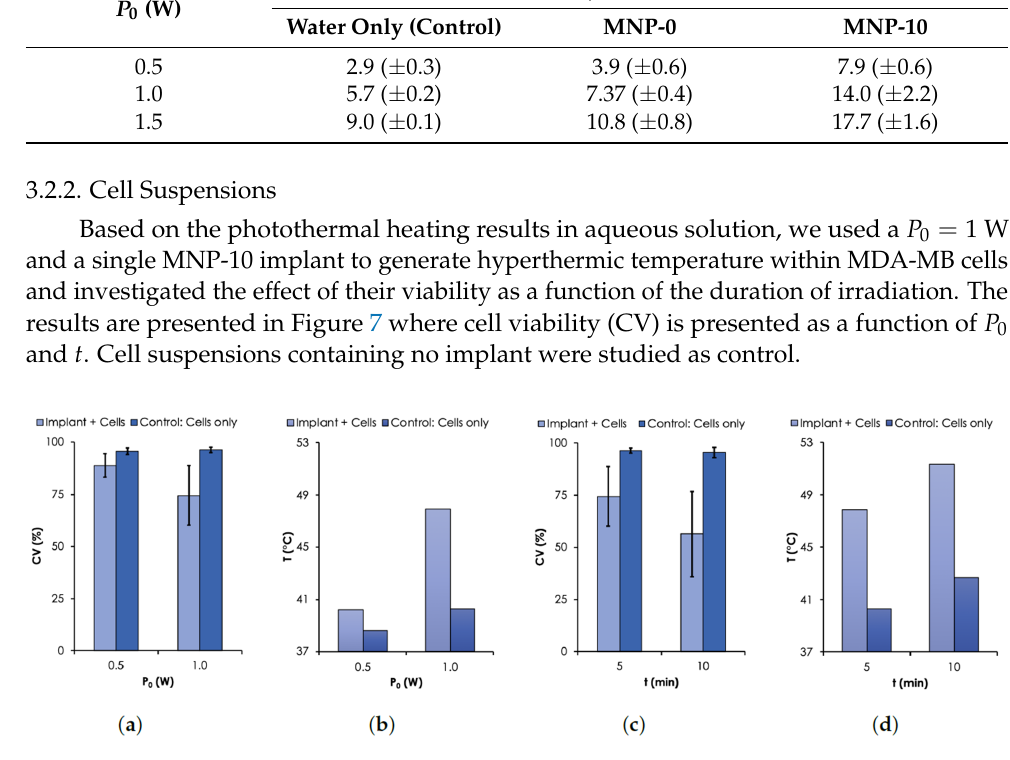
Figure 7. Cell Viability (CV) results. CV was assessed with Trypan Blue assay using MDA-MB-231 breast cancer cells. ( a ) CV and ( b ) T as a function of P 0 (0.5–1.0 W, λ = 810 nm). ( c ) CV and ( d ) T as a function of time. For all measurements, an initial T 0 = 37 ◦